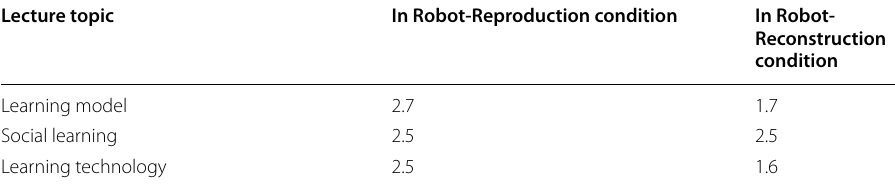
Table 4 Average numbers of paralanguage for emphasis per slide Lecture topic